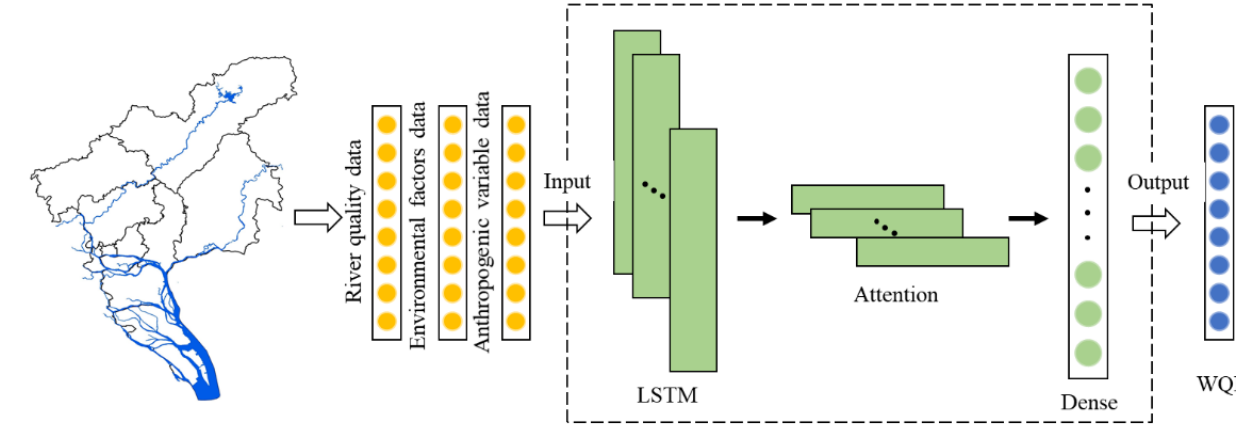
Figure 6. WQI prediction modeling methodology structure.